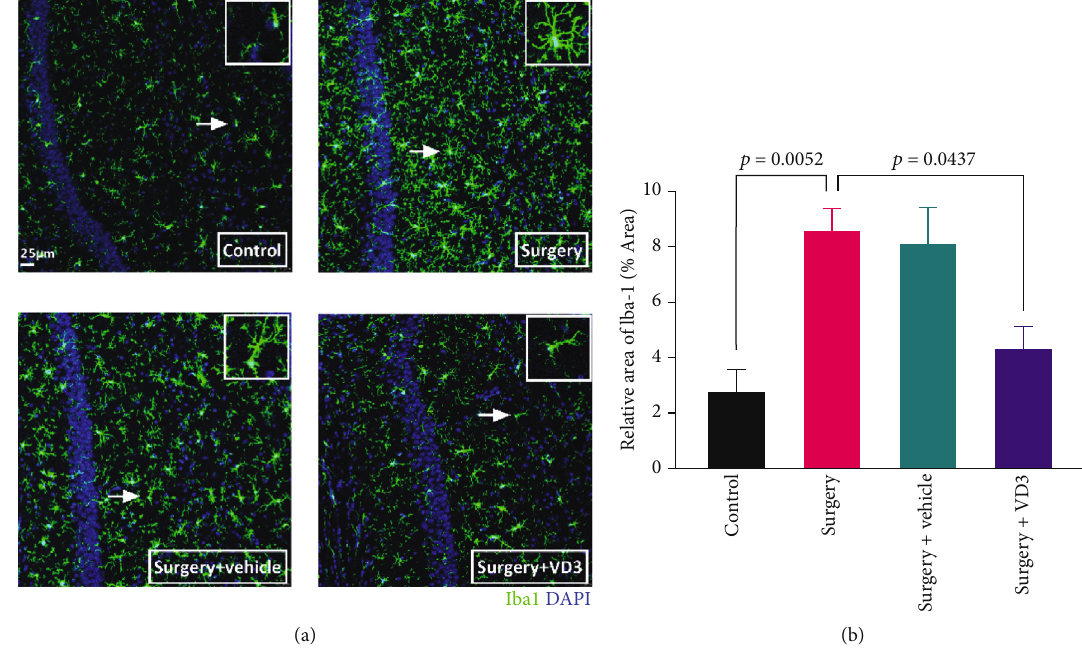
Figure 6: Microglial activation in the hippocampus following surgery. (a) Immunostaining for Iba-1 in the CA1 region of the hippocampus. The scale bar is 25 μ m. (b) Quanti fi cation of Iba-1-positive cells. Data are presented as means ± SD ( n = 4 per group).